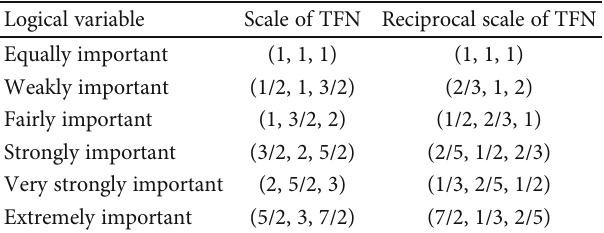
Table 1: Scale of triangular numbers with di ff erent